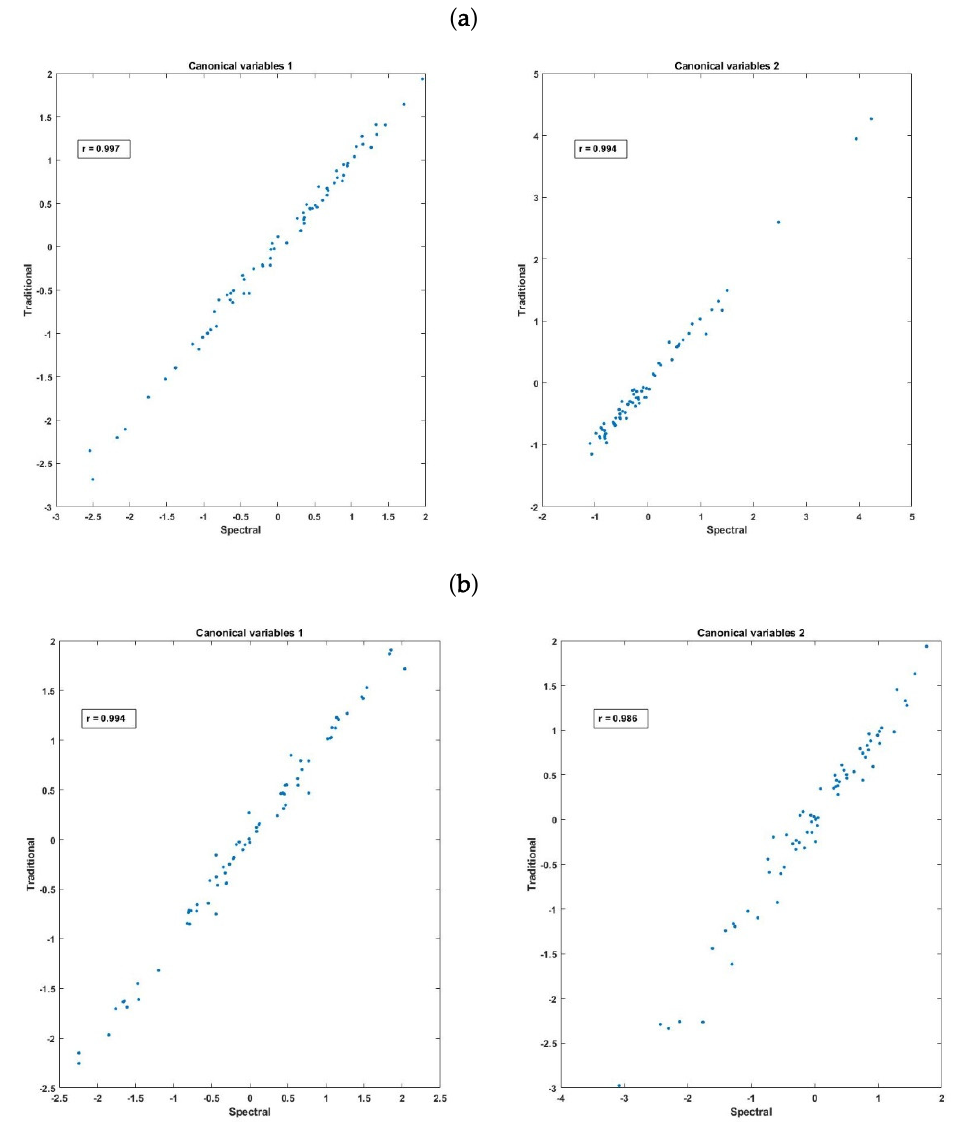
Figure 6. First two canonical variables calculated from the traditional measurements and (a) the fluorescence spectra and (b) the diffuse reflectance data.